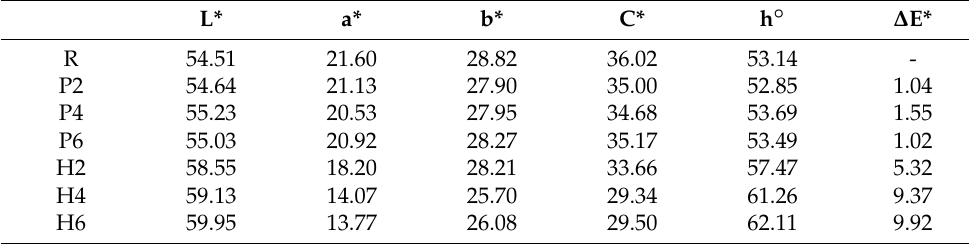
Table 4. Lightness (L*), chromatic values (a* and b*), chroma (C*), hue angle (h ◦ ) and the colour difference ( ∆ E) between the control samples (R) and those with additives (P and